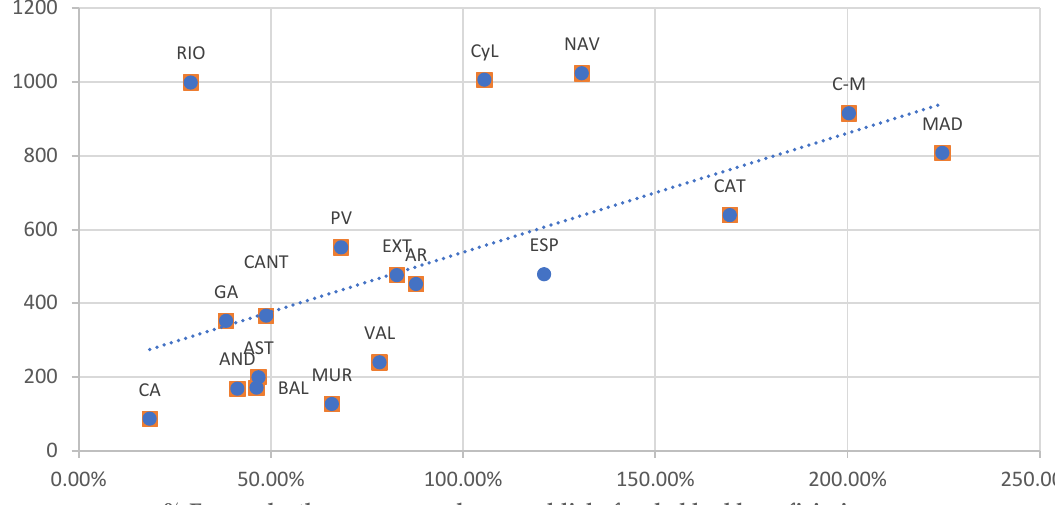
Figure 2. Excess mortality among care home publicly funded bed beneficiaries and accumulated incidence/100,000 inhabitants in each Autonomous Community. Source: Authors’ work using data from the Centro Nacional de Epidemiología [28] and IMSERSO [27].